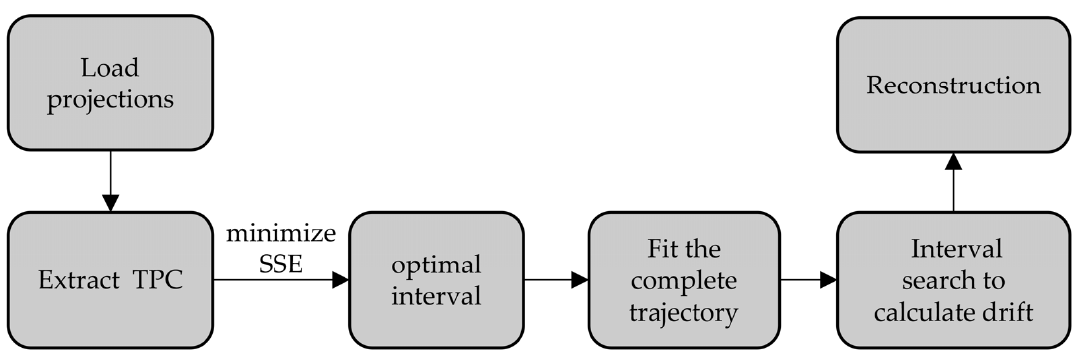
Figure 4. A flow diagram of the proposed method.